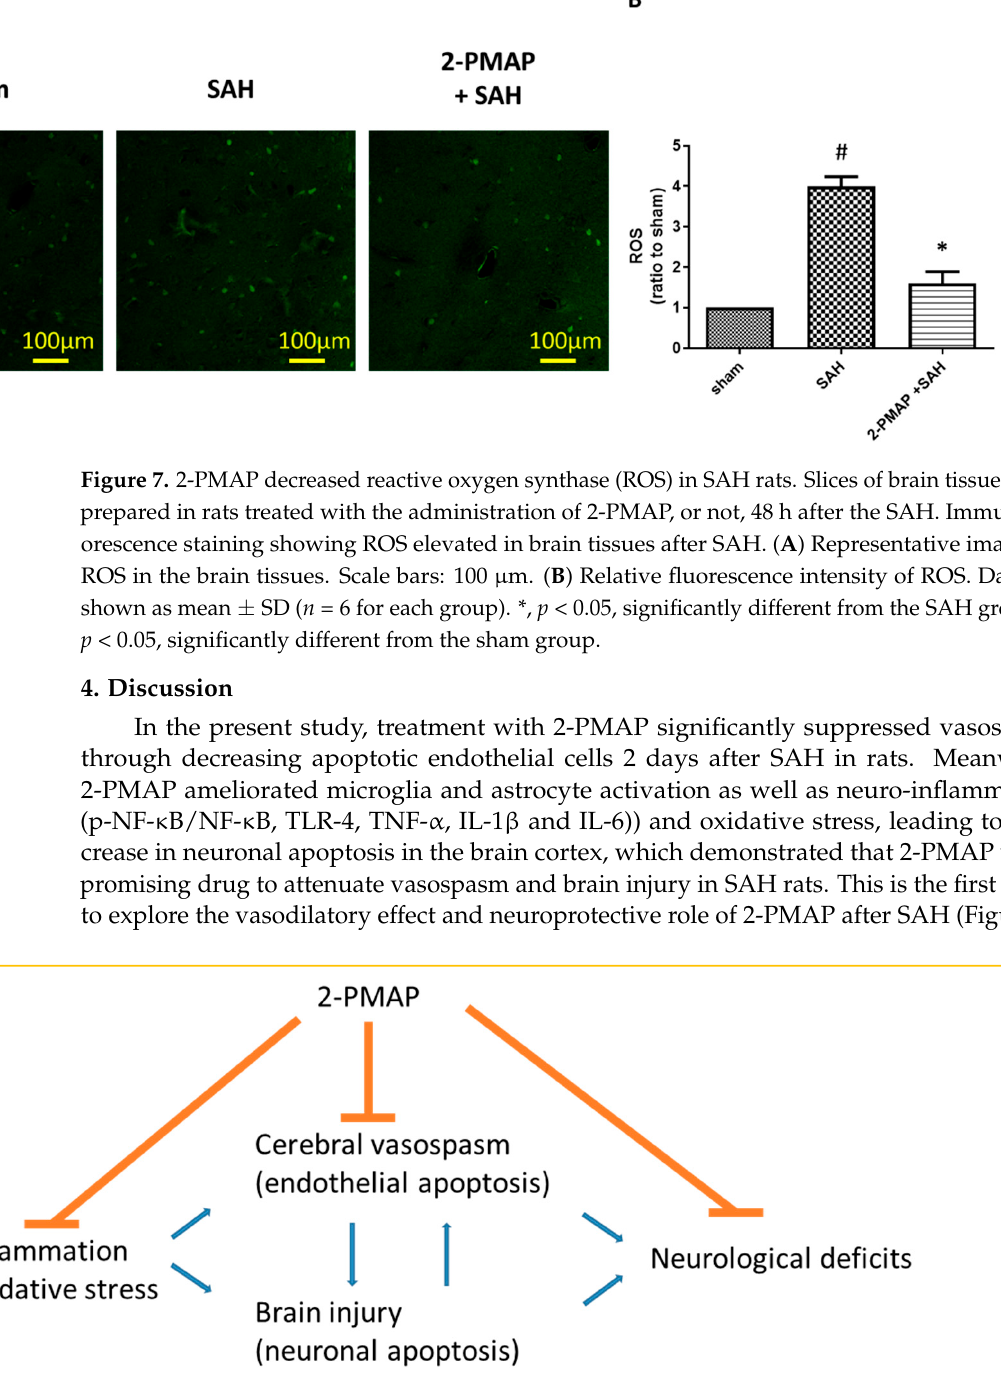
11 of 17 Figure 6. 2-PMAP decreased astrocyte activation in SAH rats. Slices of brain tissues were prepared in rats treated with the administration of 2-PMAP, or not, 48 h after the SAH. Immunofluorescence staining showing reactive astrogliosis in brain tissues after SAH. ( A ) Representative images of reac- tive astrogliosis in the brain tissues. Scale bars: 100 µm. ( B ) Relative fluorescence intensity of GFAP. Data are shown as mean + SD ( n = 6 for each group); *, p < 0.05, significantly different from the SAH group. #, p < 0.05, significantly different from the sham group. 3.7. 2-PMAP Decreased ROS in SAH Rats Mitochondrial dysfunction leads to the overproduction oxygen radicals, the release of apoptogenic proteins and the generation of mitochondria-related inflammation, which